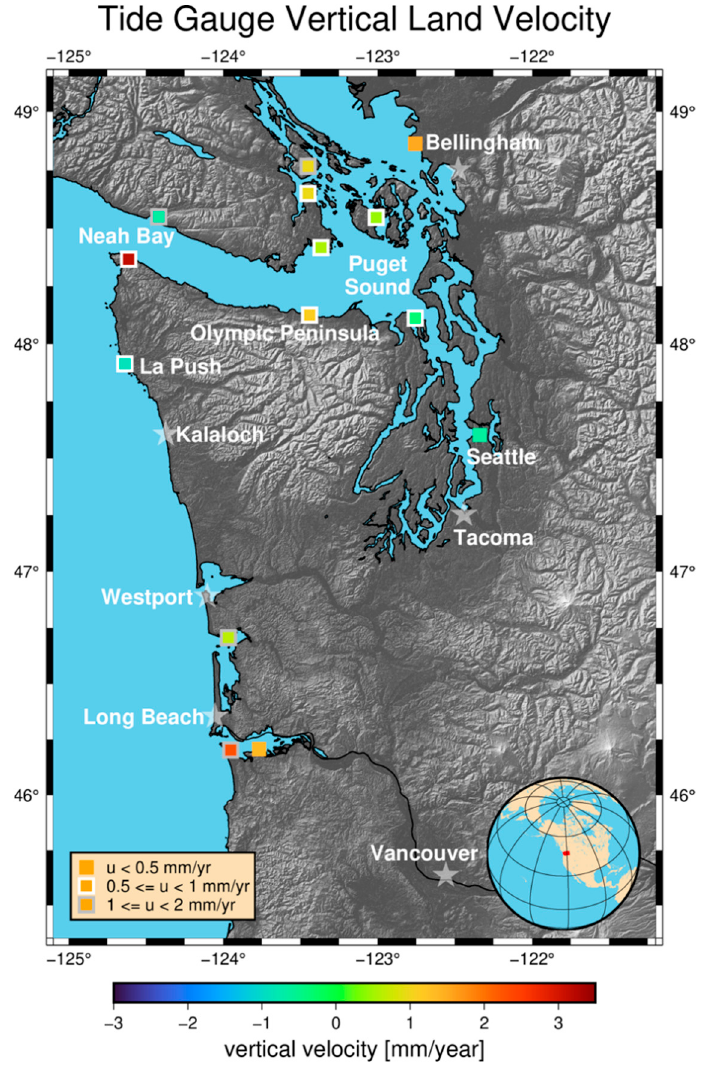
Figure 2. Measurements of vertical land movement derived from water level differencing of tide gauges. Vertical velocity is denoted by marker color and uncertainty is denoted by marker outline, expressed as millimeters per year (mm/yr). Places and areas mentioned in this study are labeled with stars and names in white. North is up.